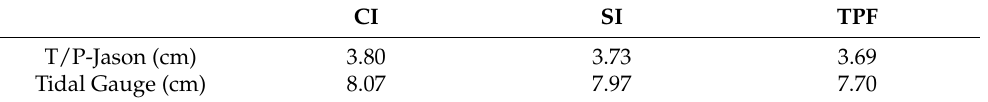
Table 6. RMS errors between observations and simulations obtained by different approaches.